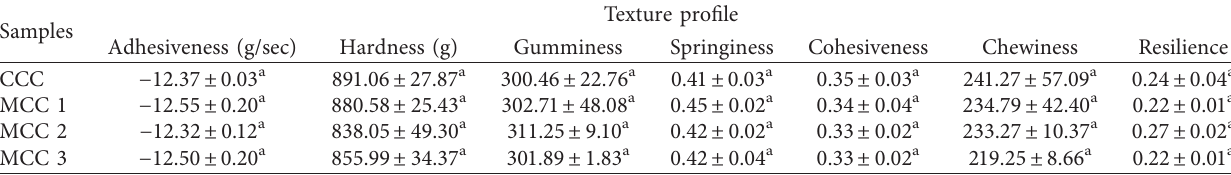
Table 9: Texture profile of colored chicken meat obtained from a genuine supplier and three different markets. Samples